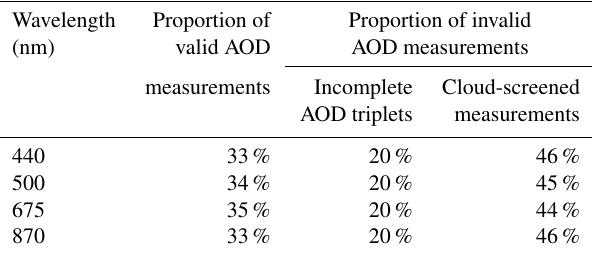
Table 4. Results from the AMODv2 quality control algorithm from 4763 AOD measurements taken during laboratory rooftop testing. Attempts where zero measurements were logged for a triplet at- tempt are omitted from the